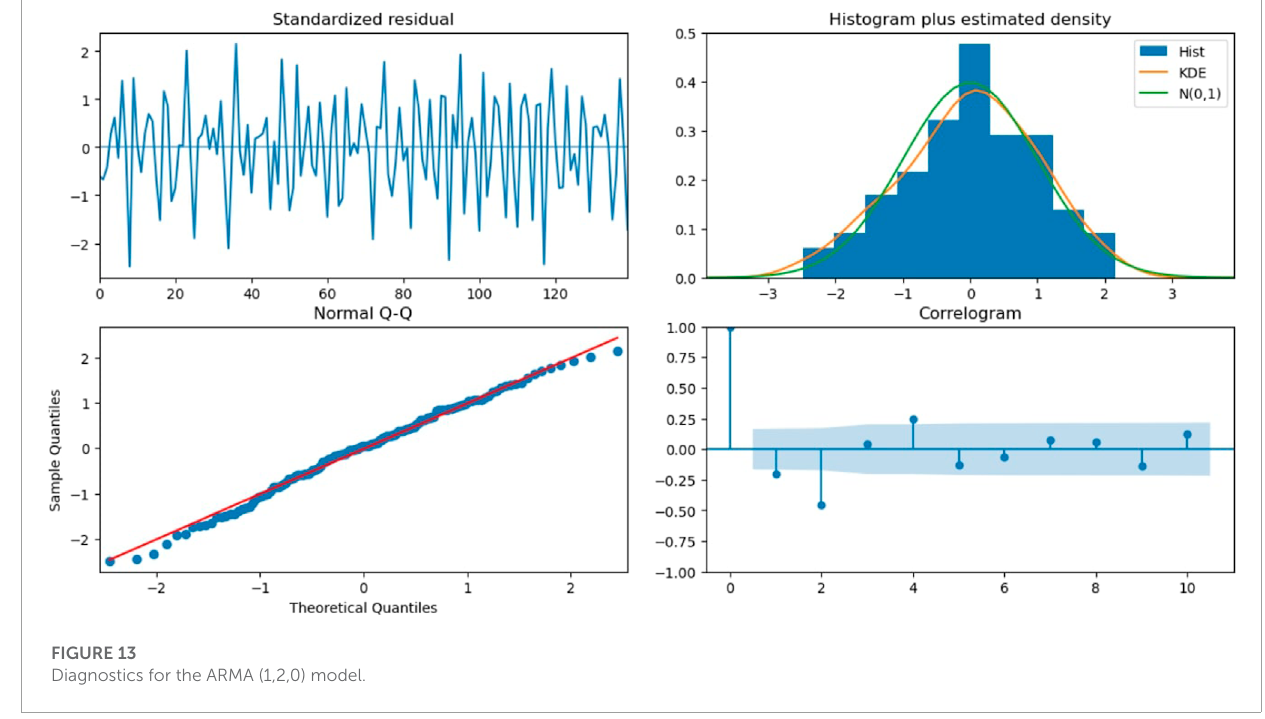
FIGURE 13 Diagnostics for the ARMA (1,2,0) model.